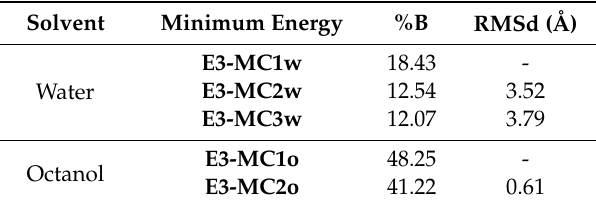
Table 4. %B and RMSd values of the most probable energy minima for E3, obtained after MC simulations conducted in both solvents. RMSd values (Å) are calculated on the heavy atoms of E3 compared to the global energy minima ( E3-MC1w and E3-MC1o